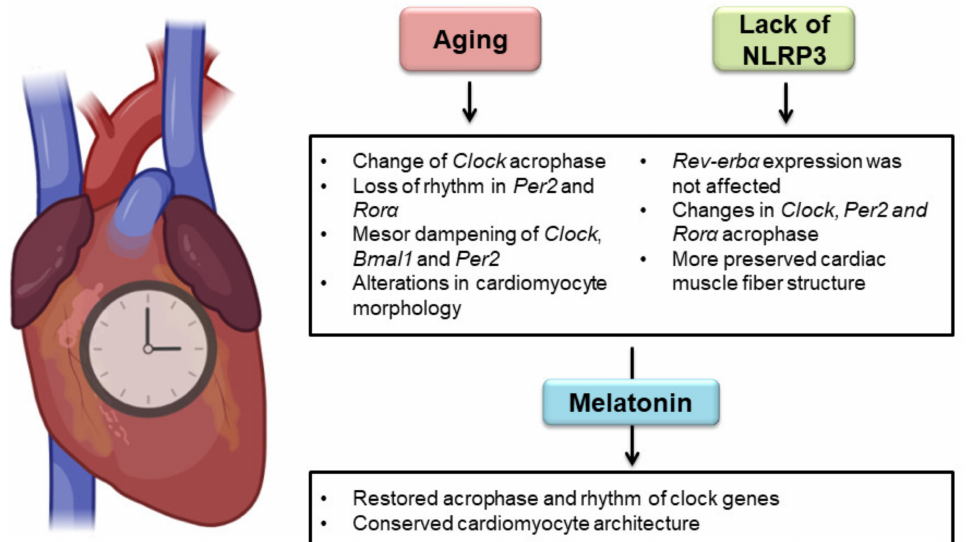
Figure 7. Effect of aging, NLPR3 inflammasome, and melatonin therapy on the cardiac circadian system. Aging produced minor changes in the Clock acrophase, loss of rhythmicity in Per2 and Ror α , and a tendency towards dampening the mesor. NLRP3 inflammasome modified the acrophase of Clock , Per2 , and Ror α . Expression of Rev-erb α was not influenced by mouse genotype. Melatonin re-established the acrophase and rhythm of these three genes. Morphological analysis revealed age-associated impairments in cardiac muscle fibers, which were less harmful in NLRP3-knockout mice. Melatonin treatment preserved the structure of cardiomyocytes in all experimental